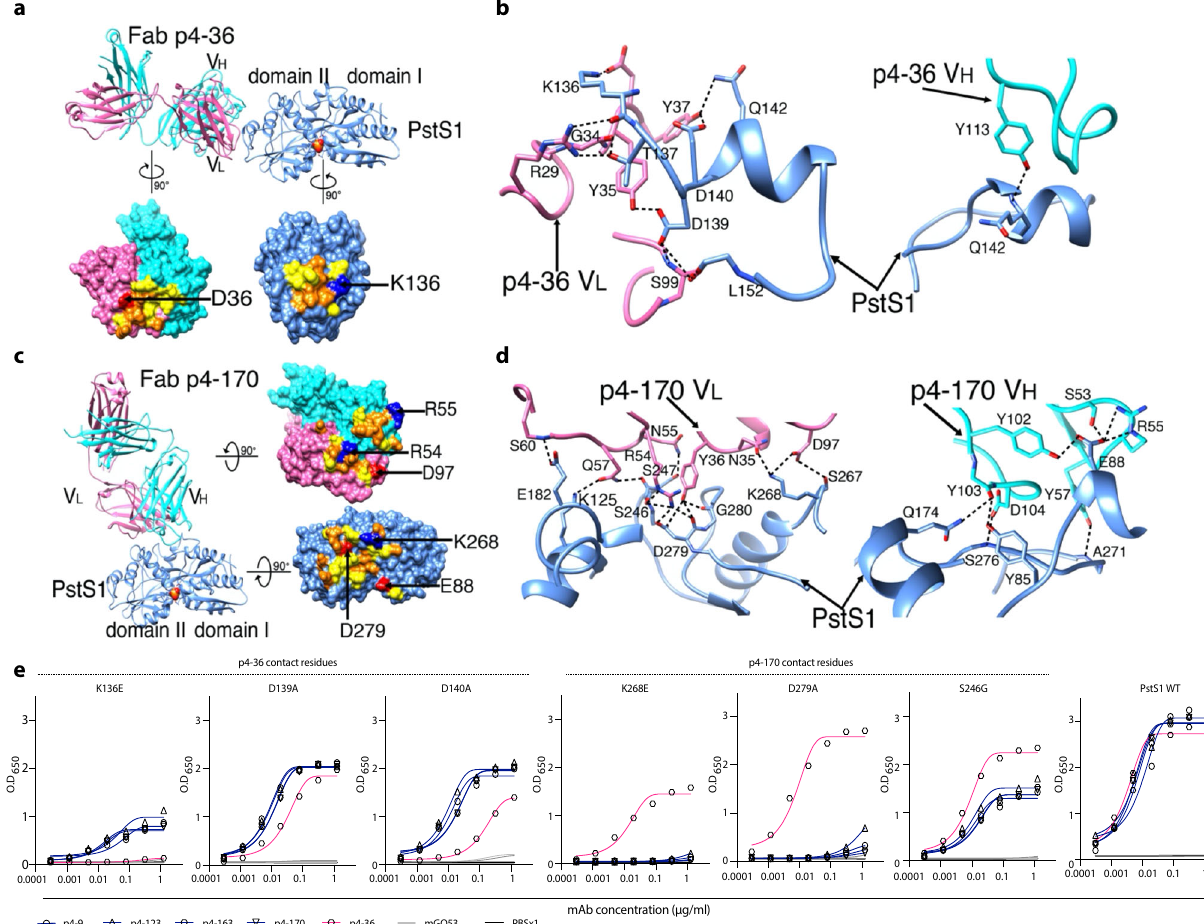
Fig. 4 MAbs p4 – 170 and p4 – 36 recognize different epitopes on top of PstS1. a Top: Ribbon diagrams show the crystal structure of PstS1 in a complex with Fab p4 – 36 (PDB ID 7DM1). The Fab p4-36 heavy and light chains are colored corn fl ower cyan and hot pink, respectively. The PstS1 structure is colored blue. The bound phosphate (Pi) is represented as fi lled balls with oxygen and phosphorus atoms colored red and yellow, respectively. Bottom: an open-up surface-shadowed representation showing the contact interface. Residues involved in hydrogen bonds and Van der Waals contacts are highlighted in orange and yellow, respectively. Positively and negatively charged residues involved in the formation of the salt bridges are highlighted in blue and red, respectively. b Close-up view of the interface between PstS1 and Fab p4-36. The dashed lines indicate hydrogen bonds and salt bridges. c Left: Ribbon diagrams show the crystal structure of PstS1 in complex with Fab p4-170 (PDB ID 7DM2). Right: An open-up surface-shadowed representation showing the contact interface. The color schemes used are the same as in ( a ). d Close-up view of the interface between PstS1 and Fab p4-170. The dashed lines indicate hydrogen bonds and salt bridges. e Four Clone 1 variants (mAbs p4-9, p4-123, p4-163, and p4-170, dark blue), and mAb p4-36 (magenta), as well as negative control mAb mGO53 20 (gray), were tested for binding by ELISA to six-point mutant PstS1 proteins. The binding curves of PstS1 mutated in p4-170 contact residues K268E, D279A, and S246G, as well as the PstS1-mutated p4-36 contact residues K136E, D139A, and D140A are shown. The binding curves to wild-type PstS1 are shown in the right panel of the fi